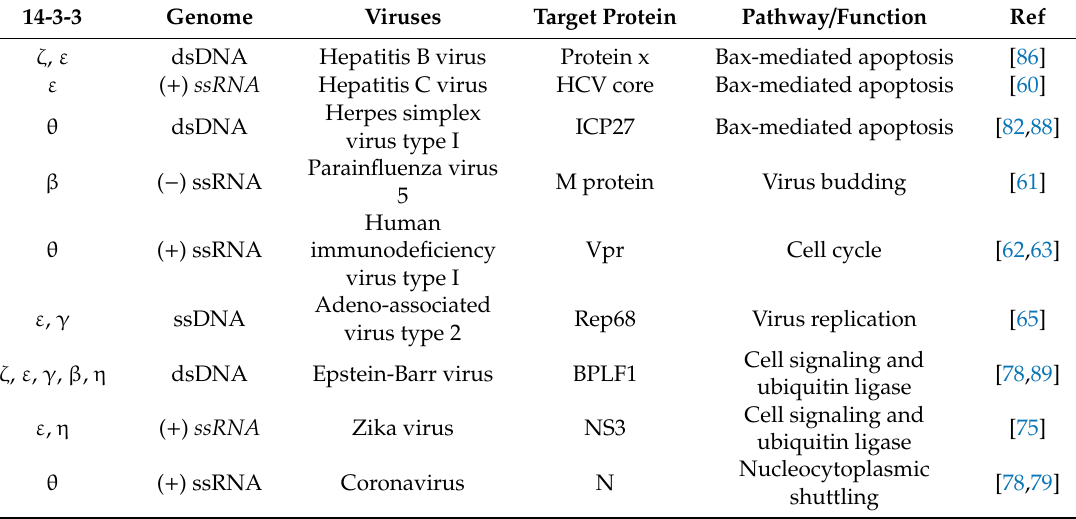
Table 2. Summary of the 14-3-3 family’s roles in di ff erent